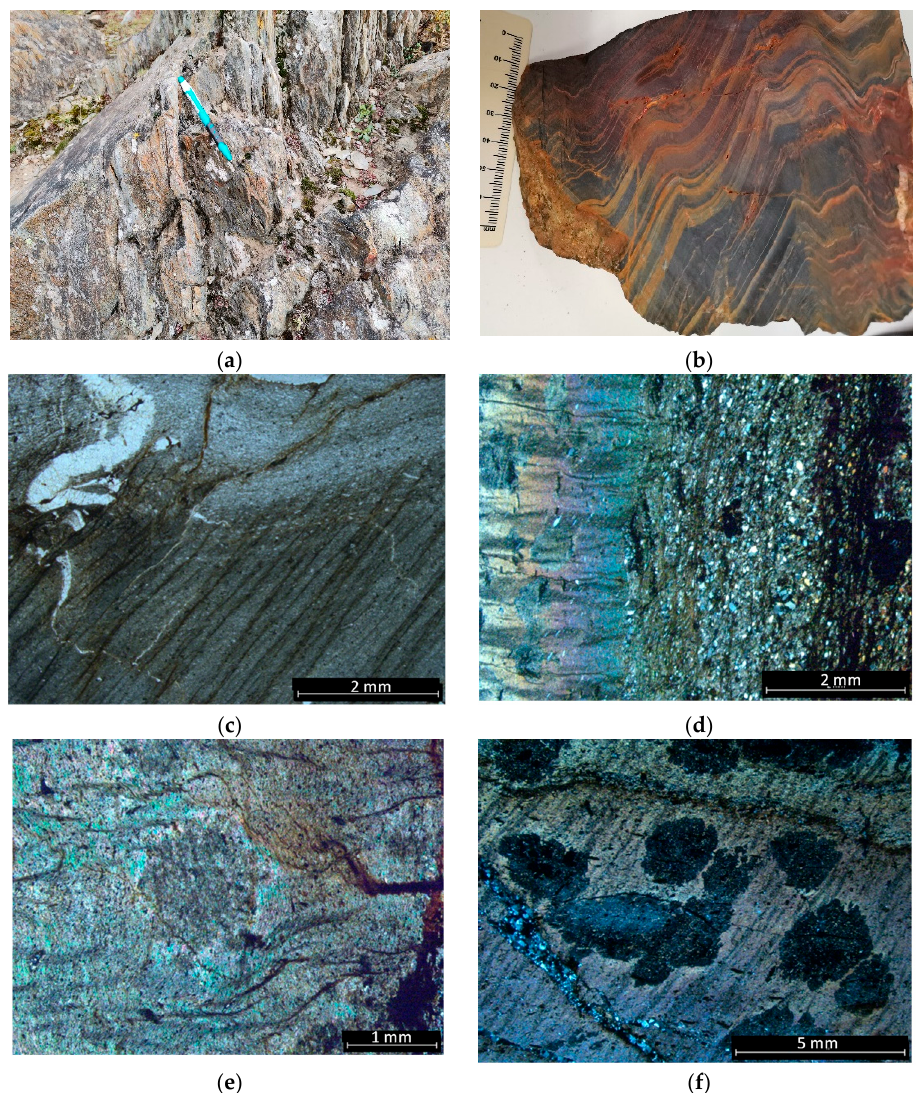
Figure 2. Metasediments of CXG in Regoufe area: ( a , b ) field and macroscopic stratigraphic layering with pelitic and semi-pelitic beds; ( c , d ) photomicrographs of S 0 //S 1 and the crenulation cleavage restricted to the pelitic beds; ( e , f ) photomicrographs of strongly altered cordierite porphyroblasts, illustrating its syn-kinematic character with the crenulation cleavage. Photomicrographs ( c , e ) were taken in plane-polarized light and ( d , f ) in crossed-polars.